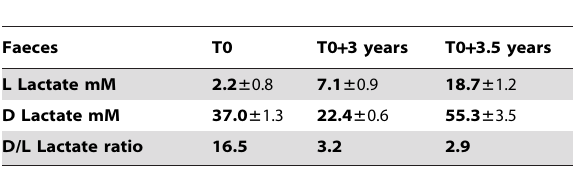
Table 4. Faecal D and L lactate concentrations (mM) in S12 patient over time from sequential sampling (T0, T0 + 3 years and T0 + 3.5